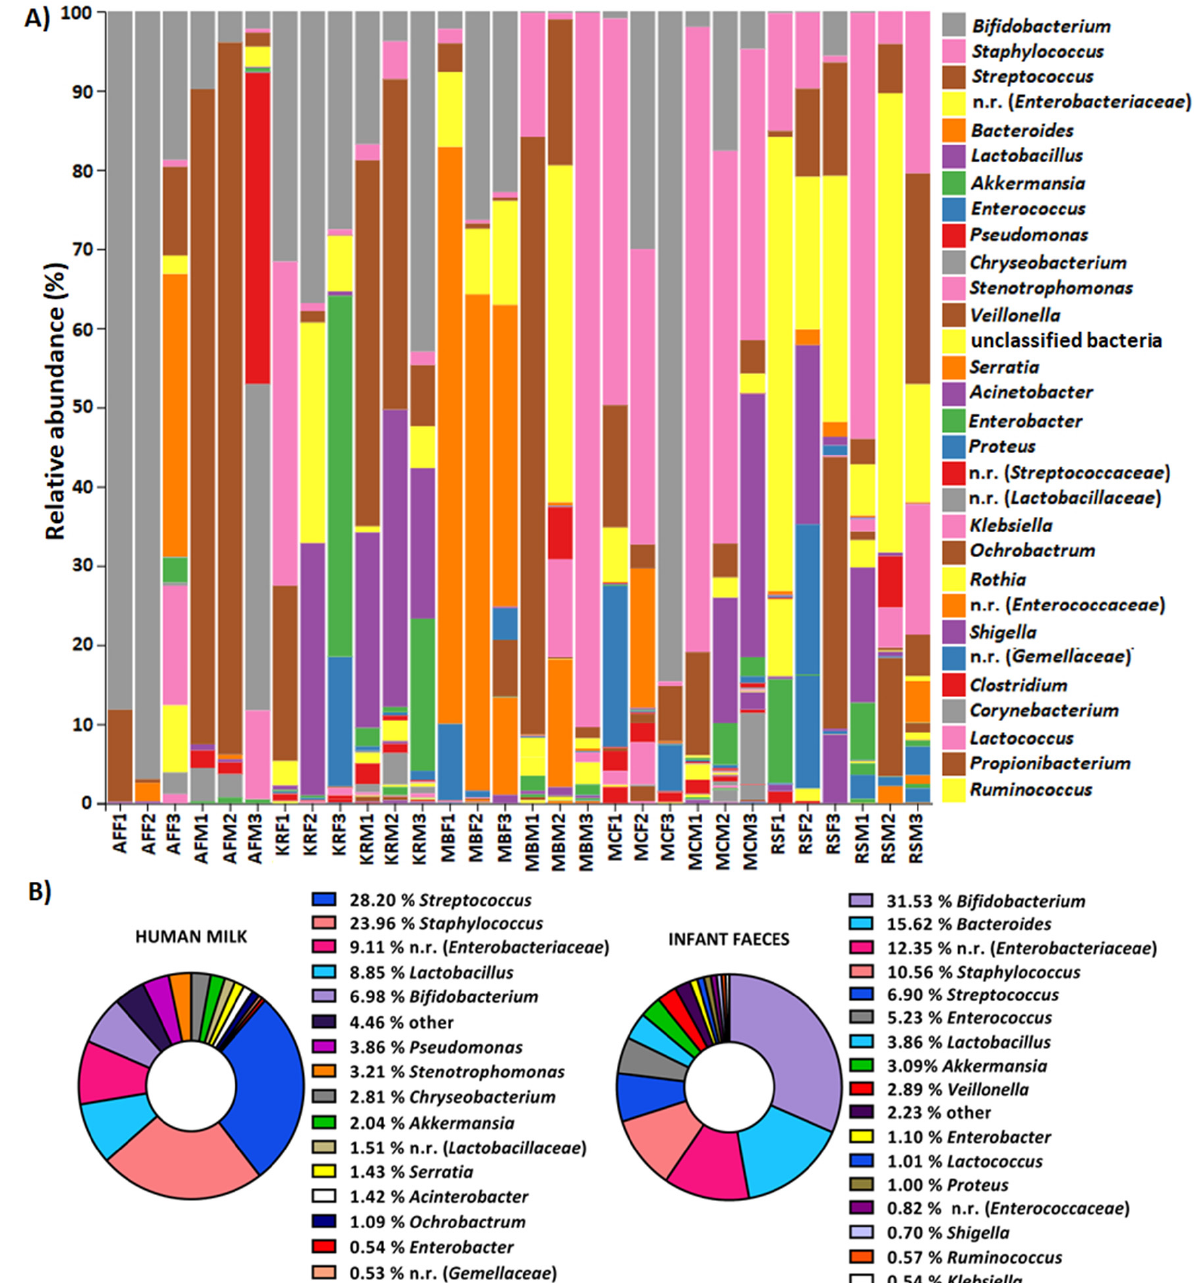
Figure 3. Relative abundance of OTUs at genus level of: ( A ) human milk samples from the same mother (M), i.e., faeces (F) from the same infant, ( B ) all human milk and infant faeces samples. OTUs with an average representation of less than 0.5% are classified as other. n.r.—not recognised genus from the family listed in parentheses.